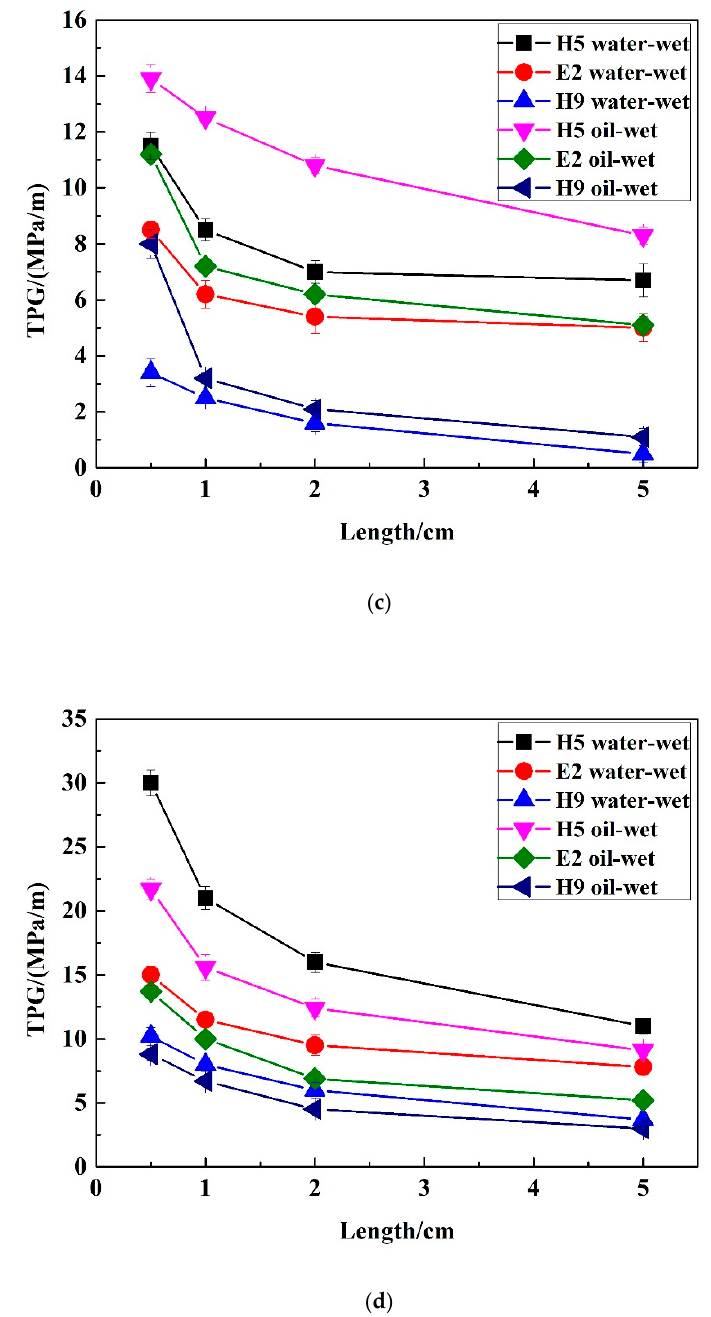
Figure 8. The TPG of ( a ) water and ( b ) oil in oil-wet cores, and the comparison of the TPG of ( c ) water and ( d ) oil in water-wet cores and oil-wet cores.